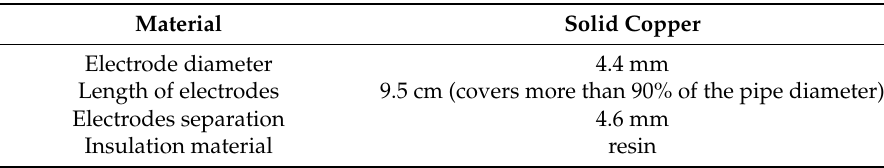
Figure 4. Equipment for stimulus-response technique. Table 1. Characteristics of the